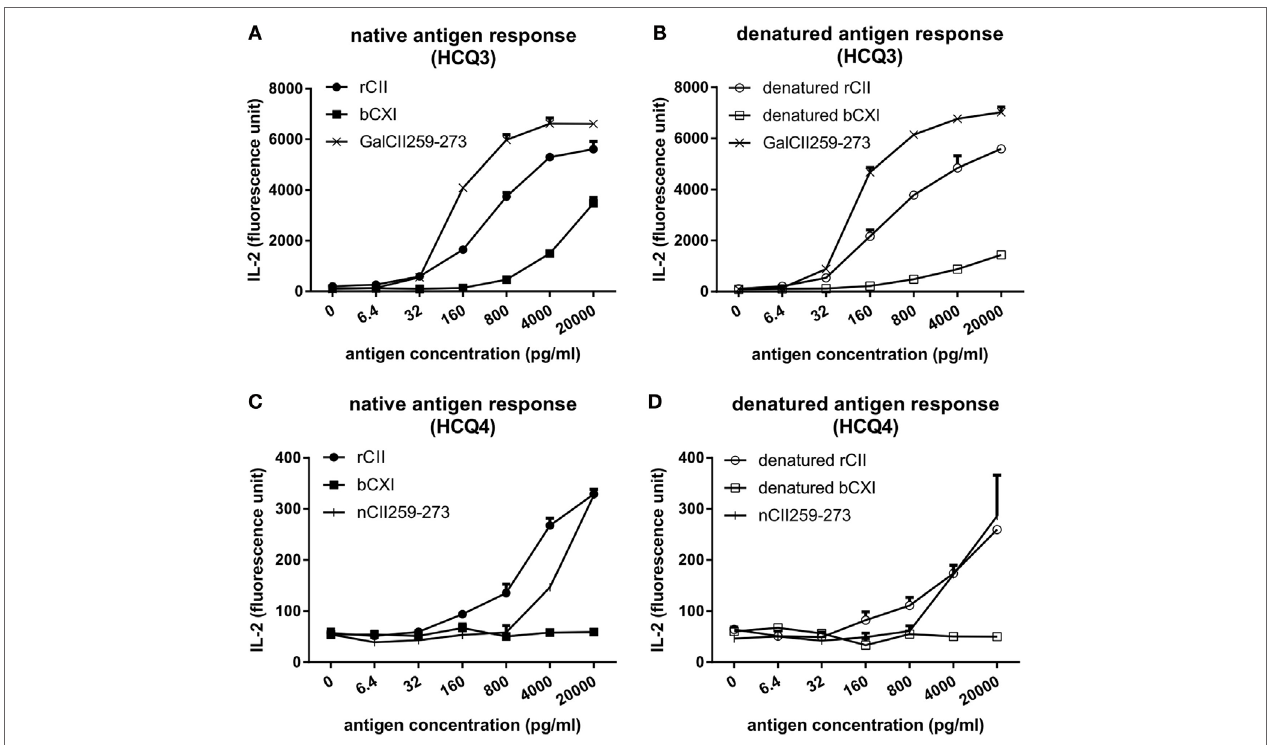
FigUre 2 | T cell recall assay for CII and CXI. The response of HCQ3 and HCQ4 hybridoma to native (a,c) and denatured (B,D) collagens. The supernatant was collected and the IL-2 secretion was measured by cytokine enzyme-linked immunosorbent assay. Glycosylated CII259-273 peptide (GalCII259-273) and naked CII259-273 peptide (nCII259-273) were served as positive control peptides for HCQ3 and HCQ4 hybridoma, respectively. rCII, rat Collagen II; bCXI, bovine collagen XI.